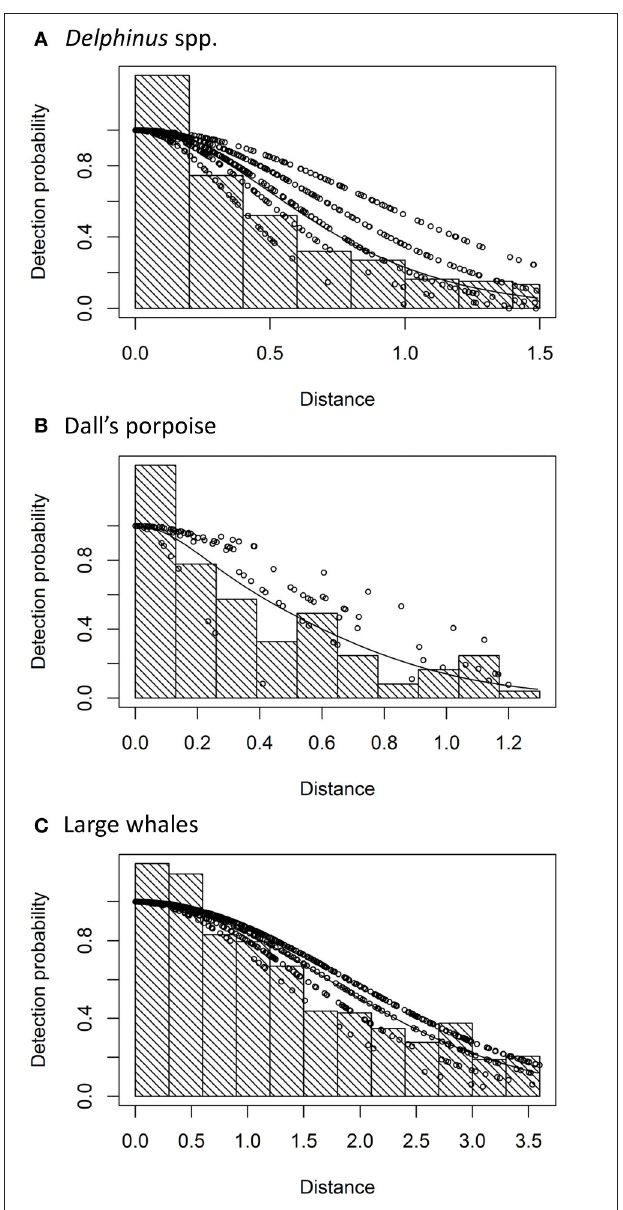
FIGURE 2 | Half-normal detection function models with Beaufort sea state as a covariate fit to perpendicular sighting distances (km) for (A) all Delphinus spp., (B) Dall’s porpoise, and (C) all large whales. The histogram shows the distribution of observed perpendicular distances of the sightings, binned to facilitate data analysis (Buckland et al., 2001). The dots are the probability of detection dependent on perpendicular distance and sea state, with lowest sea states on the top (Beaufort 0–1) and highest (Beaufort 5) on the bottom. The solid line shows the average estimated detection function.